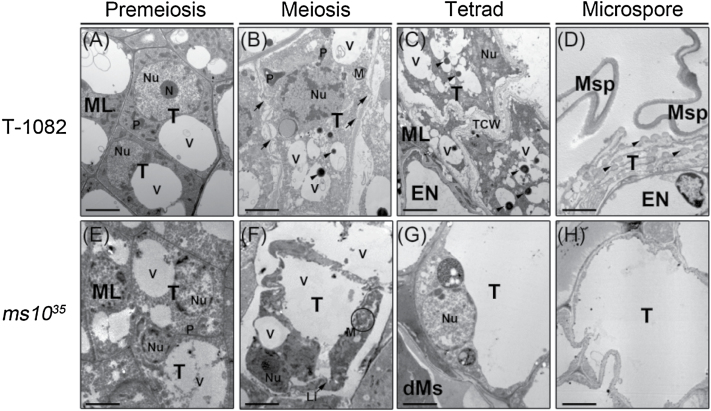
TEM analysis of T-1082 and ms10
35 tapetum. Tapetal cells of T-1082 (A–D) and ms10
35 (E–H) anthers at pre-meiotic (A, E), meiotic (B, F), tetrad (C, G), and microspore (D, H) stages. At the meiotic stage, T-1082 anthers (B) contained nuclei, plastids, mitochondria, and vacuoles. Arrowheads indicate electron-dense deposits in the vacuoles. Arrows indicate plasmodesmata. In ms10
35 anthers, the nuclei appeared normal, but larger vacuoles were generated. Mitochondria (indicated by a circle) and lipid structures were also detected (F). At the tetrad stage, T-1082 anthers (C) showed an irregular tapetum cell wall, and a degenerated nucleus and cellular organelles. Arrowheads indicate electron-dense deposits in the vacuoles. ms10
35 anthers (G) had extremely vacuolated tapetum and intact nuclei and organelles. At the microspore stage, T-1082 anthers (D) exhibited degenerated tapetal cells and production of orbicules (arrowheads). ms10
35 anthers (H) were completely vacuolated. dMs, degenerated meiocytes; EN, endothecium; Li, lipid deposit; M, mitochondria; ML, middle cell layer; Msp, microspore; N, nucleolus; Nu, nucleus; P, plastid; T, tapetum; TCW, tapetal cell wall; V, vacuole. Bars, 2 μm.